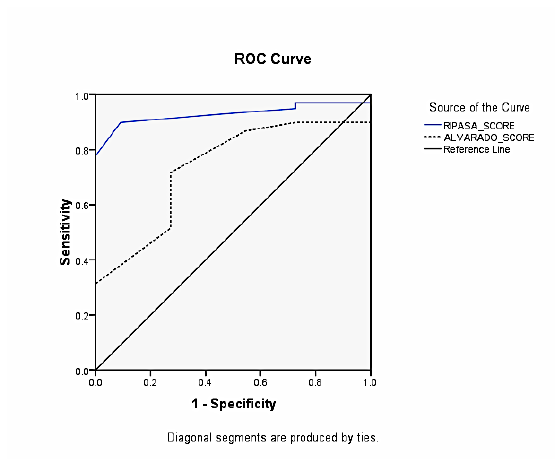
Figure 1. ROC plots for RIPASA and Alvarado scoring